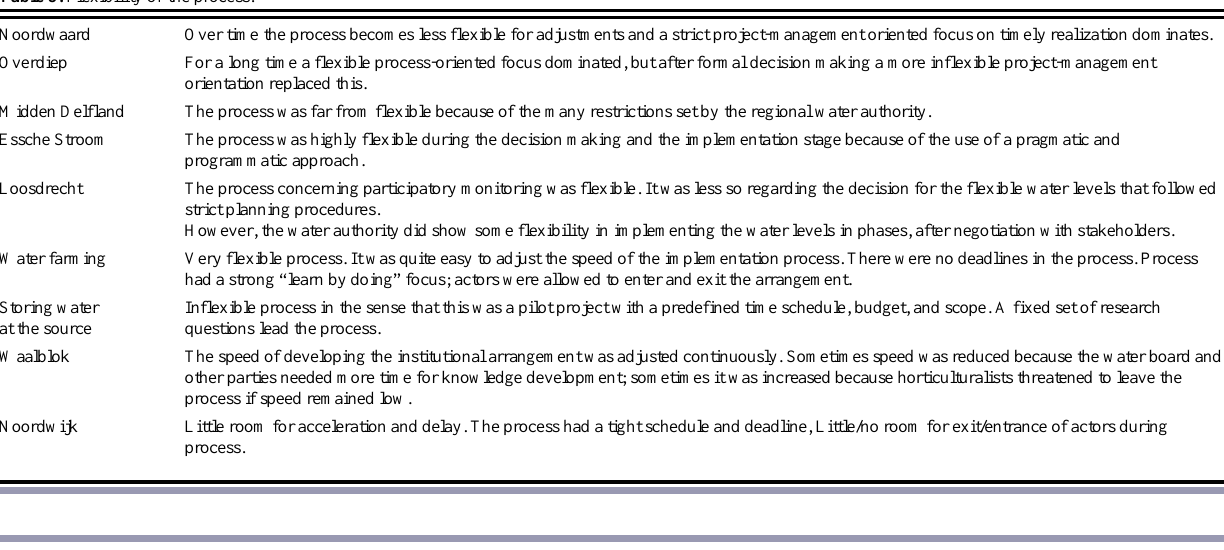
Table 5. Flexibility of the